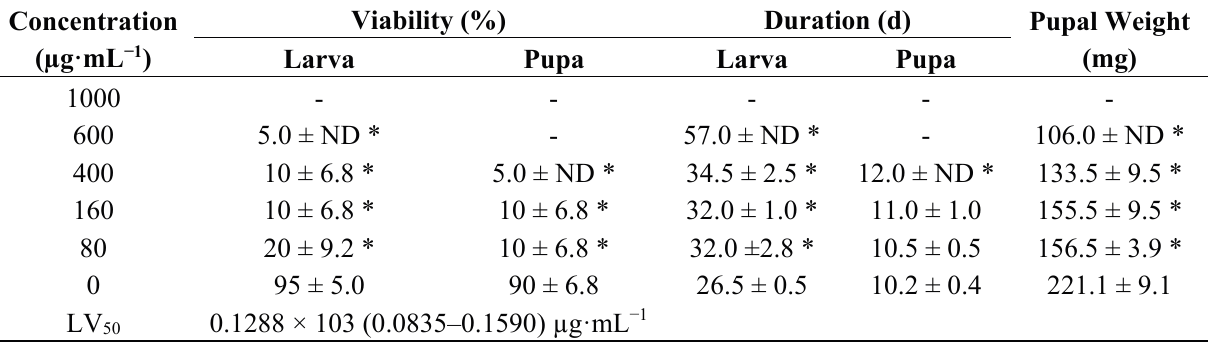
Table 2. Insecticide and insectistatic activities of S. ballotiflora essential oil against S. frugiperda . Concentration (µg·mL − 1